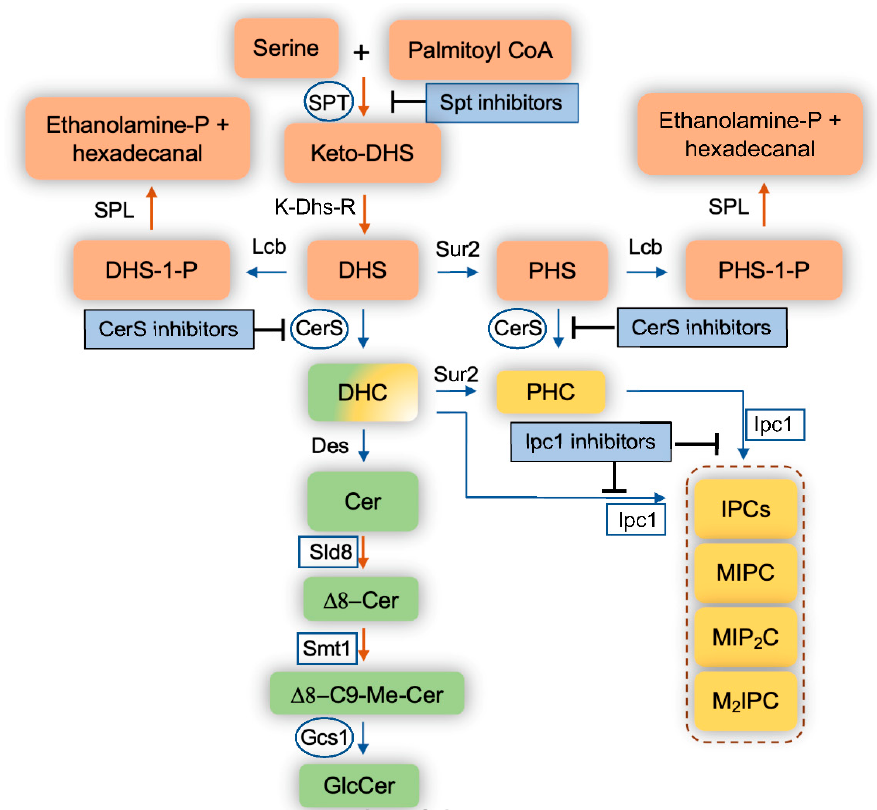
Figure 1. Schematic representation of the sphingolipid pathways in fungi. Blue arrows indicate reversible reactions. Orange arrows indicate irreversible reaction. Squares represent fungal enzymes that have no homologs in mammalian cells. Circles represent fungal enzymes that are significantly different than human homologs. DHS, dihydrosphingosine; PHS, phytosphingosine; DHS-1-P, dihydrosphingosine-1-phosphate; PHS-1-P, phytosphingosine-1-phosphate; DHC, dihydroceramide; PHC, phytoceramide; Cer, ceramide; C9-Me, C9-methyl; GlcCer, glucosylceramide; IPC, Inositol phosphoryl ceramide; MIPC, mannosyl inositol phosphoryl ceramide; MIP 2 C, mannosyl diinositol phosphoryl ceramide; M2IPC, dimannosyl inositol phosphoryl ceramide; Ethanolamine-P; ethanolamine-phosphate; SPT, serine palmitoyl transferase; Lcb, long chain base kinases; K-Dhs-R, keto-dihydrosphingosine reductase; Sur2, sphingolipid hydroxylase; CerS, ceramide synthase; Des, sphingolipid desaturase; Sld8, sphingolipid desaturase 8; Smt1, sphingolipid methyl transferase; Gcs1, glucosylceramide synthase 1; Ipc1, inositol phosphoryl ceramide synthase 1, SPL, sphingolipid lyase.